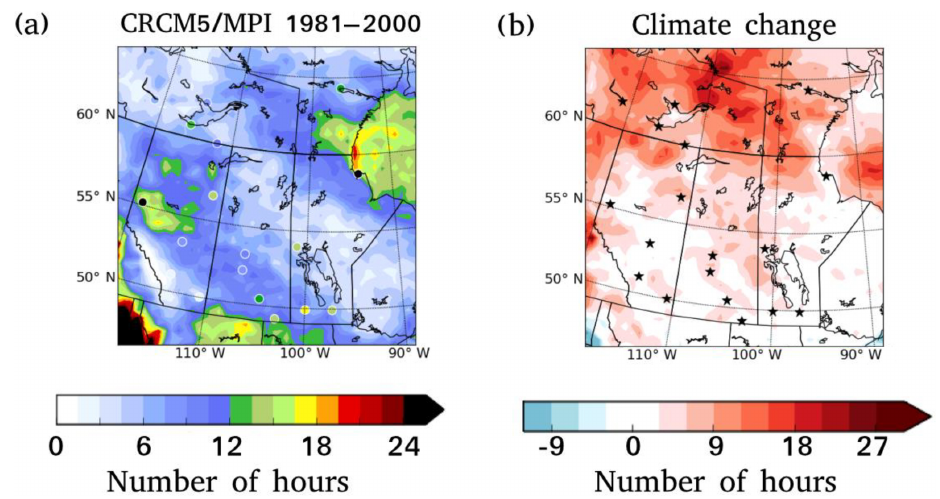
Figure 9. The mean annual number of hours of freezing rain (a) observed and simulated by the CRCM5 driven by MPI-ESM-MR for the 1981–2000 period, and (b) the change in the number of hours based on the difference between 2081–2100 and 1981–2000 assuming the RCP8.5 scenario. Observational locations are indicated by circles in (a) and stars in (b)